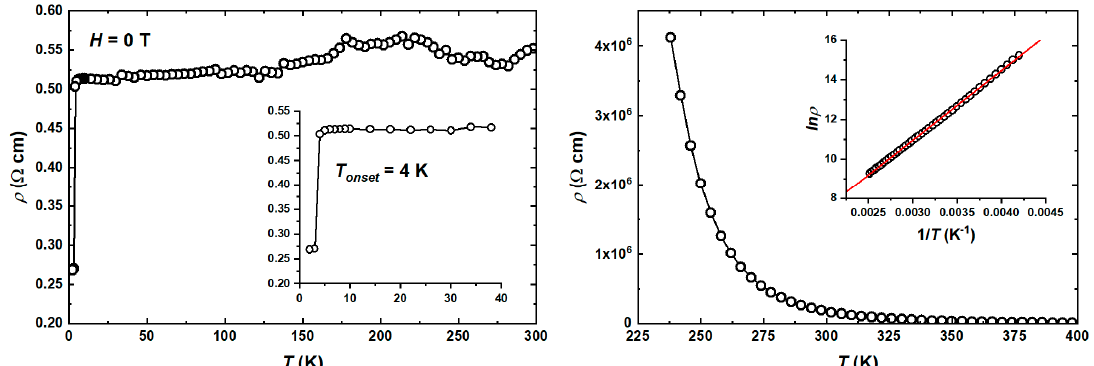
Figure 6. Electrical resistivity of CuO film grown after 5000 ALD cycles, with the thickness of 94 nm, i.e., with the maximum thickness where the phase was still appropriate [25], measured in zero magnetic field ( left panel ). The inset shows the low-temperature region ( left panel, inset ). Electrical resistivity of Si substrate ( right panel ). The ln ρ vs. 1 / T plot is shown in the inset, and the red line is a linear fit of the data ( right panel, inset ) .